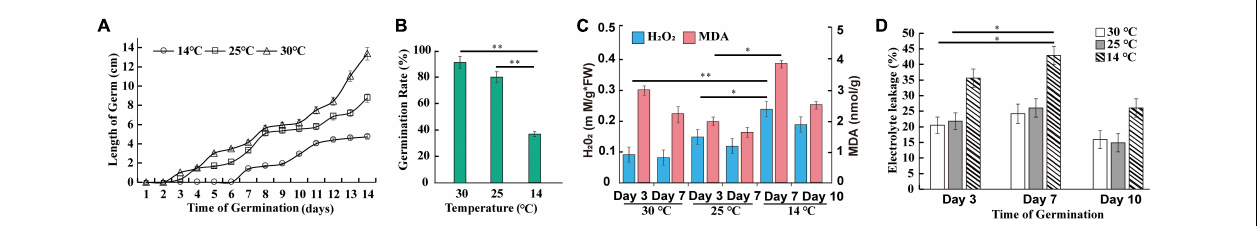
FIGURE 2 | Effect of temperature on M. micrantha seed germination at 14, 25, and 30 ◦ C. Germ length (A) , germination rate (B) , hydrogen peroxide and MDA contents (C) , and electrolyte leakage (D) of seed leachate at three key time points, covering M. micrantha seeds developmental stages. One-way ANOVA, p ≤ 0.05 (*), p ≤ 0.01 (**).